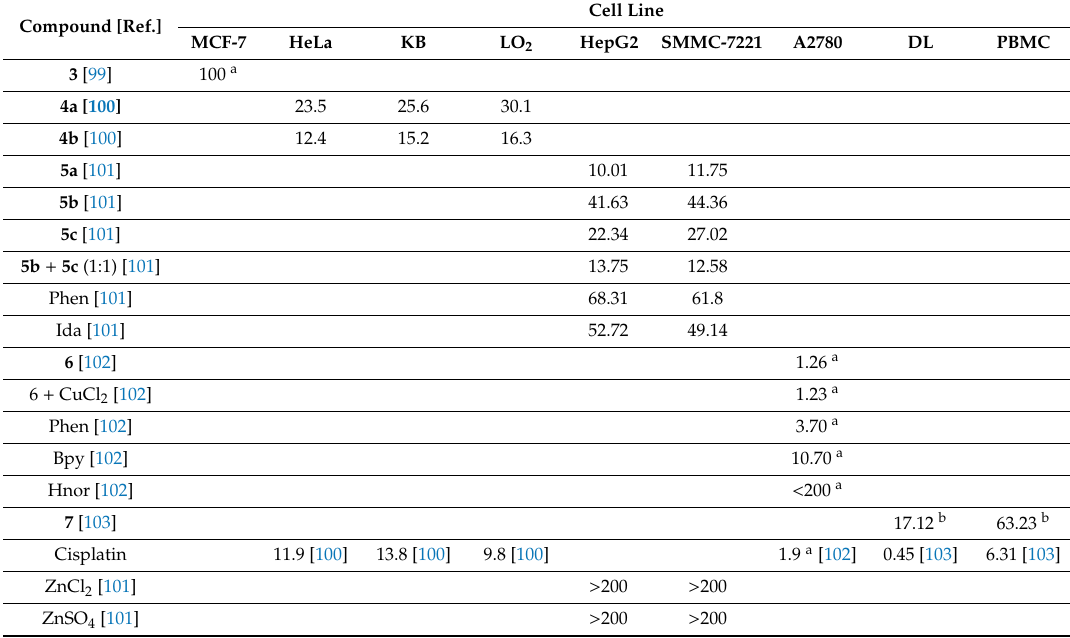
Table 2. IC 50 values ( µ M) for zinc complexes 4 – 7 , free ligands phen, ida, bpy and Hnor and the reference compounds cisplatin, ZnCl 2 and ZnSO 4 against di ff erent tumor and normal (LO 2 and PBMC) cell lines, after an incubation time of 48 h.